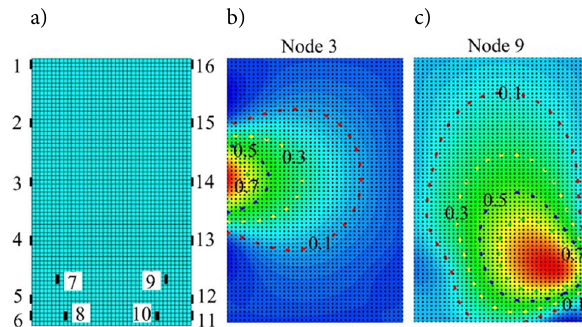
Figure 3. Finite element model: a – Measuring point; b – Node 3; c – Node